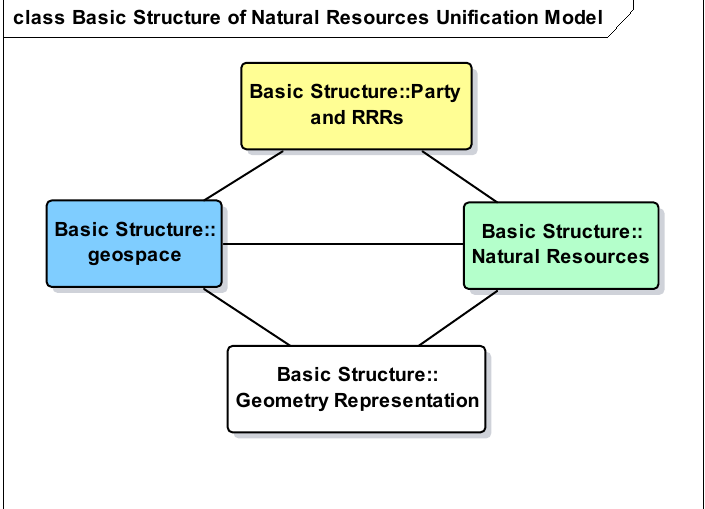
Figure 16. Relationships between the four basic classes of uniform natural resource model.